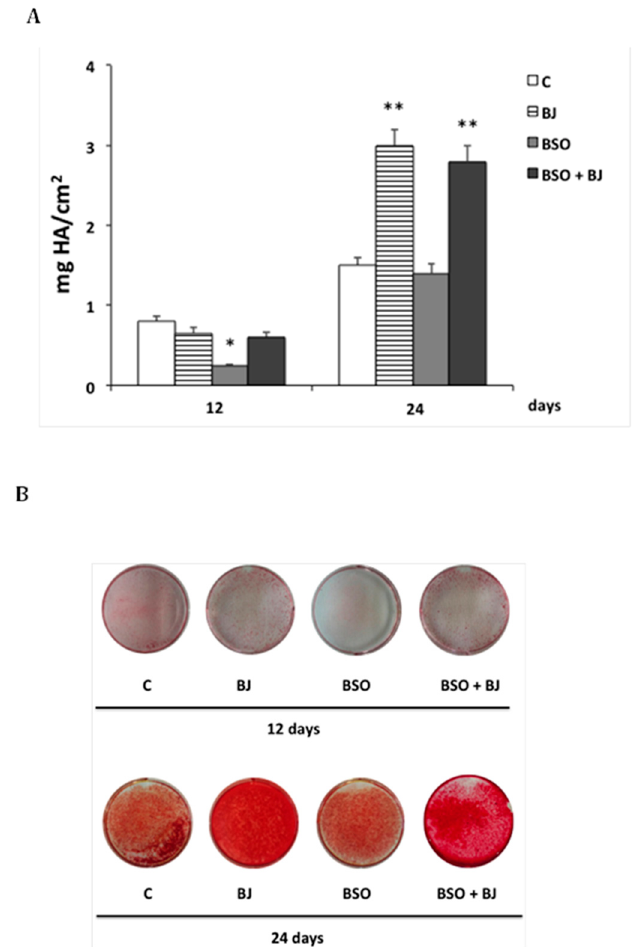
Figure 4. BJ effect on the mineralization process during differentiation of BSO-treated SaOS-2 cells. Calcium content, measured by Alizarin Red S assay, was detected in SaOS-2 cells treated or untreated with BJ, containing 15 μ g ∙ mL − 1 total soluble polyphenols (TSP), or BSO or BSO + BJ for one day in growth medium (GM) and, subsequently, treated or untreated (C; control) for 12 or 24 days in osteogenic medium (OM), as reported in Section 2. Calcium content is expressed as mg hydroxyapatite (HA) per cm 2 and values are means ± SEM of three independent experiments ( A ); * p ≤ 0.05, ** p ≤ 0.001 compared to the respective C cells. Representative images of calcium content in 12-well plates ( B ).